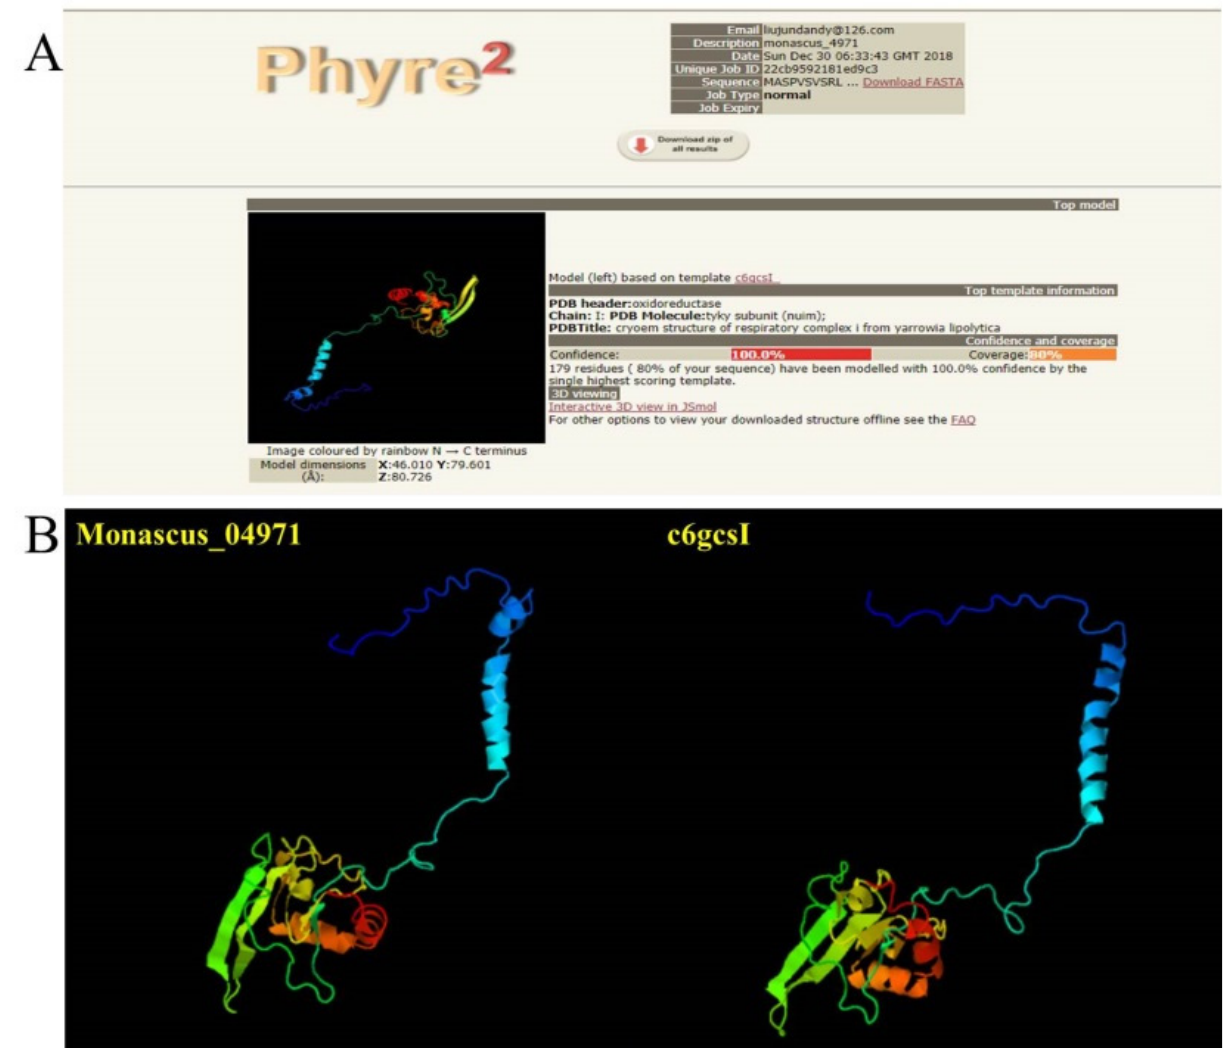
Figure 1. The predicted result of the tertiary structure of protein encoding by gene monascus _4971 using the phyre2 web server. The overview ( A ) and the tertiary structure of protein ( B ).